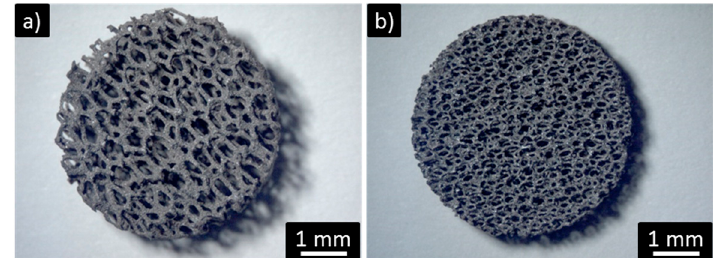
µ m ( a ) and 580 µ m ( b